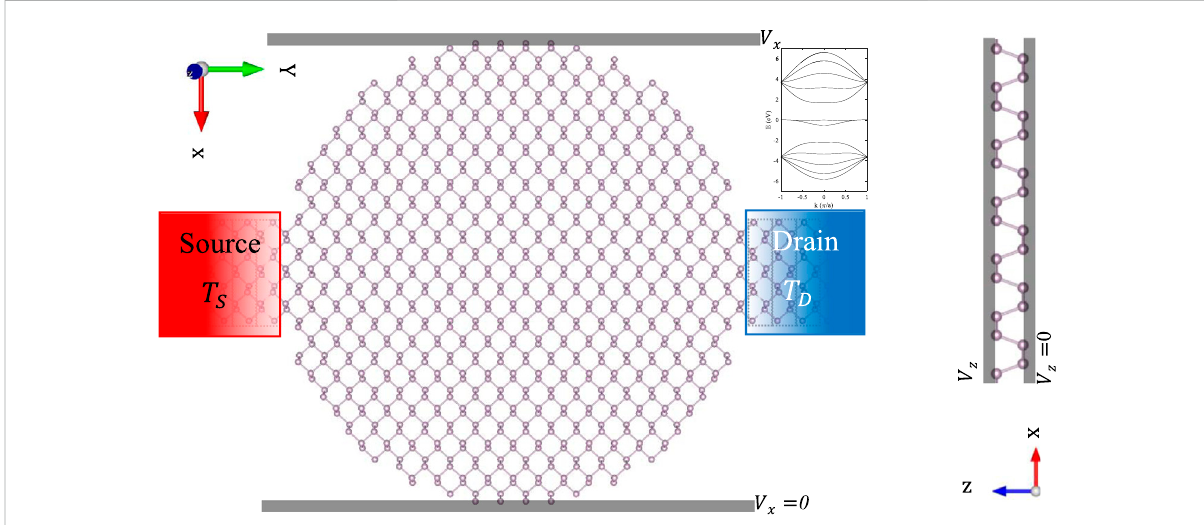
FIGURE 1 Aphosphorenenanodiskwitharadiusof3.1 nmconnectedtothetwo12ZPNRleads.Thetransportdirectionisalongthe y -axis.Thesourceand drain leads act as the hot bath and cold bath, respectively. The TB electronic band structure of the 12-ZPNR is also shown on top of the drain lead. Transverse ( E x ) and perpendicular ( E z ) fi elds are only applied to the device placed between the two leads (central region). Based on the relative position of the atoms to these lines, each atom feels a particular electric potential, which adds to its on-site energy. Electrode unit cells are shown by dotted